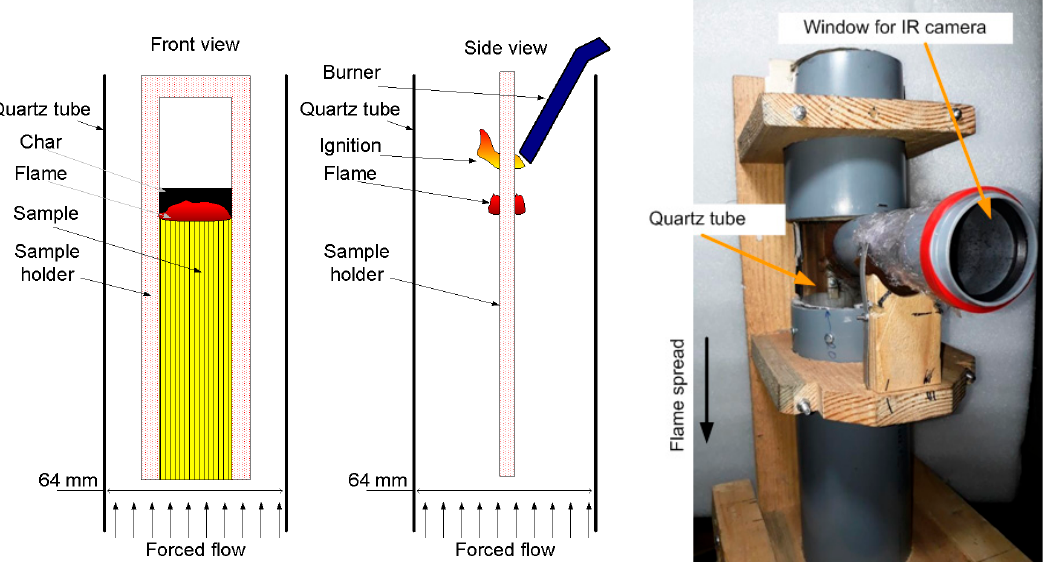
Figure 8. Schematic of the experimental setup for studying the downward flame spread (front view— left ; side view—in the center ) and its photo ( right ).